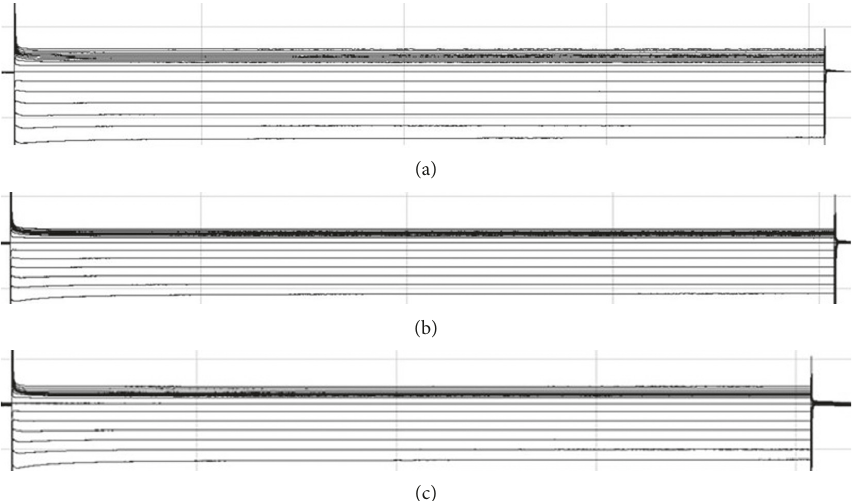
Figure 6: Effects of different-intensity continuous training on atrial tissue IKAch current density in rabbits: (a) Group C; (b) Group M; (c) Group H.